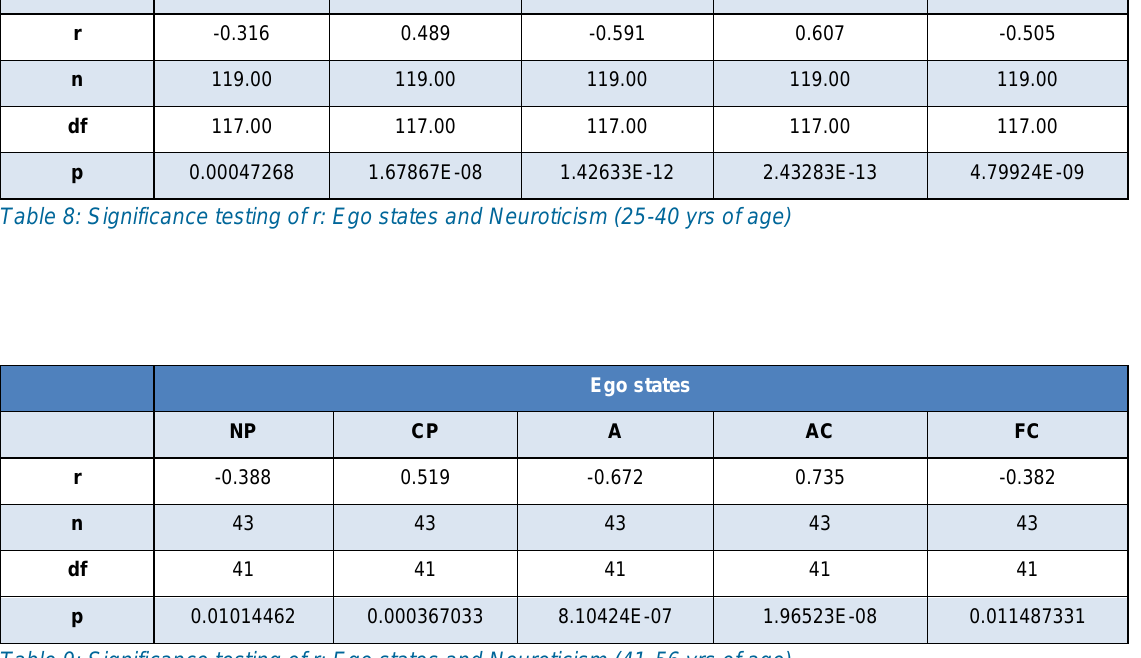
Table 9: Significance testing of r: Ego states and Neuroticism (41-56 yrs of